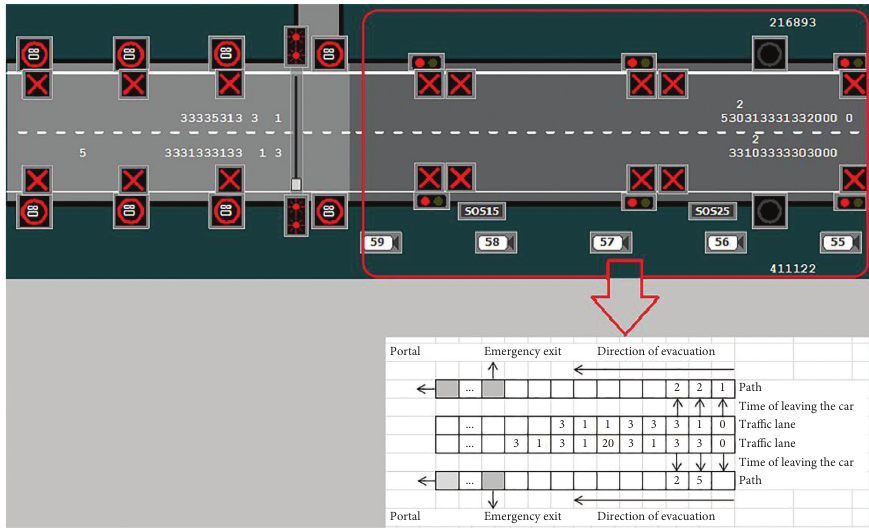
Figure 11: Interconnection of the evacuation with the CA model of traffic. Table 1: Comparison of the evacuation models.